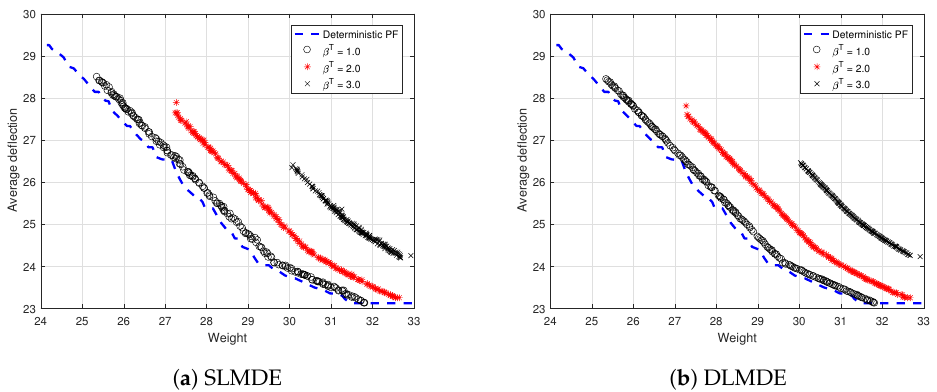
Figure 6. The obtained PO solutions by both methods for car side impact example for different β T values.